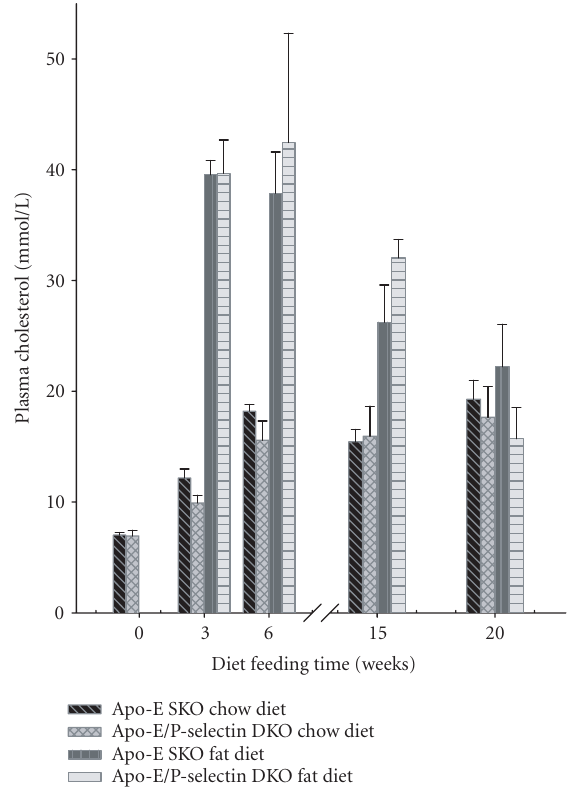
Figure 1: Plasma cholesterol levels in ApoE − / − (SKO) and ApoE − / − , P -selectin − / − (DKO) mice . Levels of cholesterol for SKO or DKO an- imals, fed a chow or fat diet, over 0 to 20 weeks. Mean ±